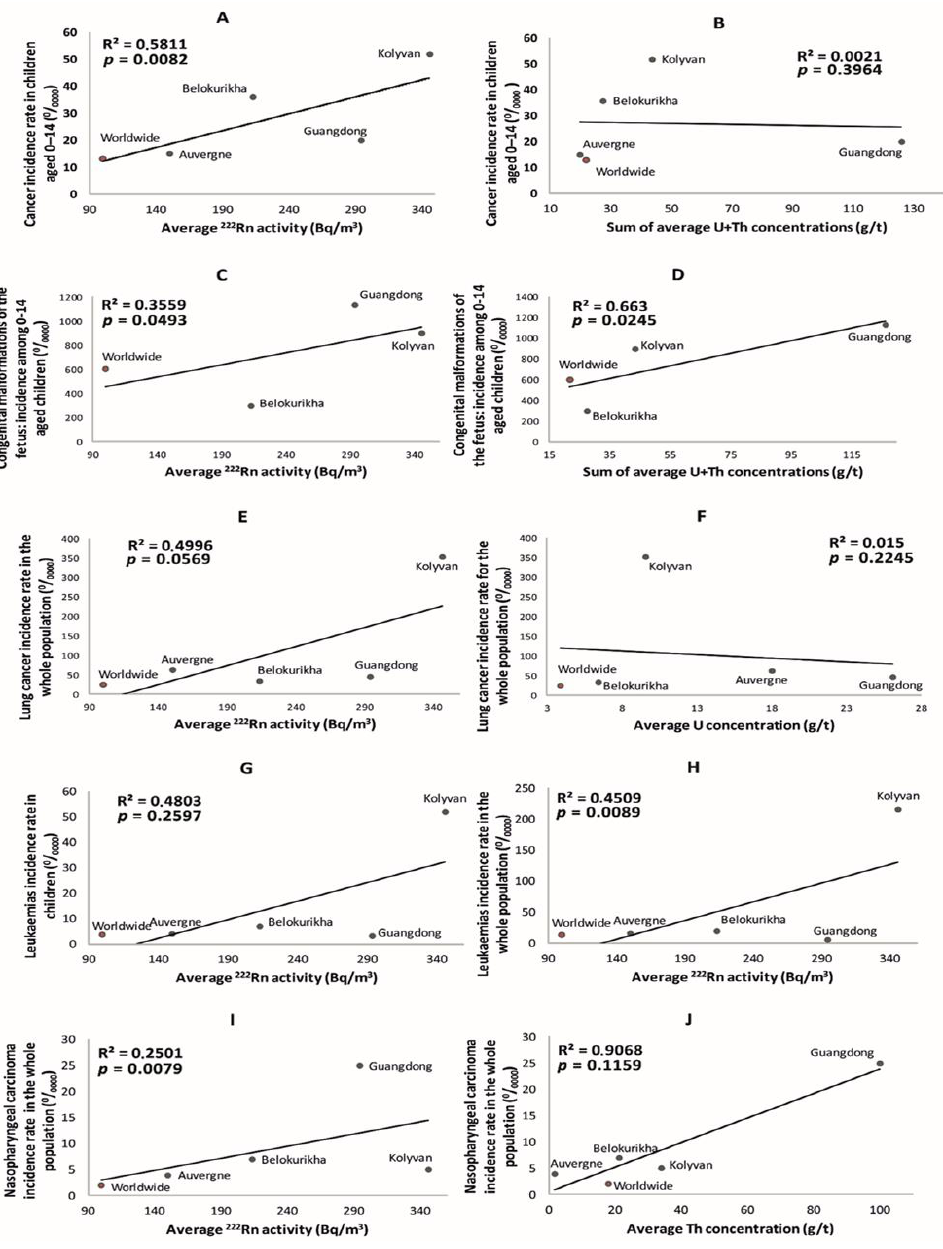
Figure 4. Dependence of all types of cancer incidence rate for children ( 0 / 0000 ) on 222 Rn activity (Bq m − 3 ) ( A ), and on the sum of U and Th concentrations in granites (g/t) ( B ). Dependence of CMF incidence rate for children ( 0 / 0000 ) on 222 Rn activity (Bq m − 3 ) ( C ), and on the sum of U and Th concentrations in granites (g/t) ( D ). Dependence of lung cancer incidence rate for the whole population ( 0 / 0000 ) on 222 Rn activity (Bq m − 3 ) ( E ), and on U concentration in granites (g/t) ( F ). Dependence of leukemia incidence rate for children ( 0 / 0000 ) ( G ) and for the whole population ( 0 / 0000 ) ( H ) on the 222 Rn activity (Bq m − 3 ). Dependence of nasopharyngeal carcinoma incidence rate for the whole population ( 0 / 0000 ) on the 222 Rn activity (Bq m − 3 ) ( I ), and on the average concentration of